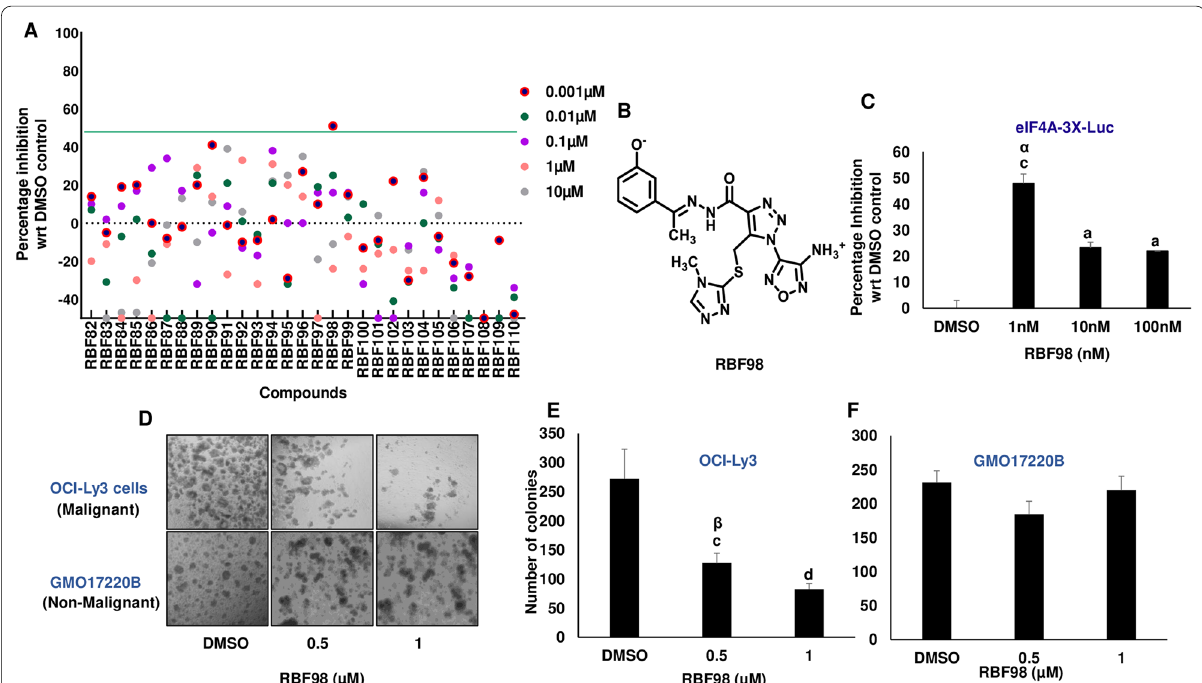
Fig. 3 eIF4A specific high throughput screen identifies small molecules with inhibitory effect. A Scatterplot of primary screen results. A total of 29 compounds were tested and luciferase signal reduced by 50% compared to control were identified and considered active. Luciferase activity ≥ results are expressed relative to values obtained in the presence of vehicle controls. Percentage inhibition was calculated and plotted in a scatter plot, n 3 biological replicates performed Mean SEM. B Structure of RBF98, a candidate inhibitor. C Percentage inhibition observed in the = ± treatment of RBF98 at various concentrations in eIF4A-3X-Luciferase Hek293T/17. D Effect of RBF98 on DLBCL colony formation. Representative image of the colony formation in OCI-Ly3 (malignant) and GMO17220B (non-malignant) cells. The total number of colonies grown in E OCI-Ly3 and F GMO17220B cells upon treatment with 0.5 and 1 µM of RBF98. Statistical analysis was performed using one-way ANOVA followed by Bonferroni’s correction analysis. a p < 0.05; c p < 0.001, d p < 0.0001 vs DMSO control groups, α p < 0.05, β p < 0.001, ¥ p < 0.0001 vs 1 mM RBF98 treated